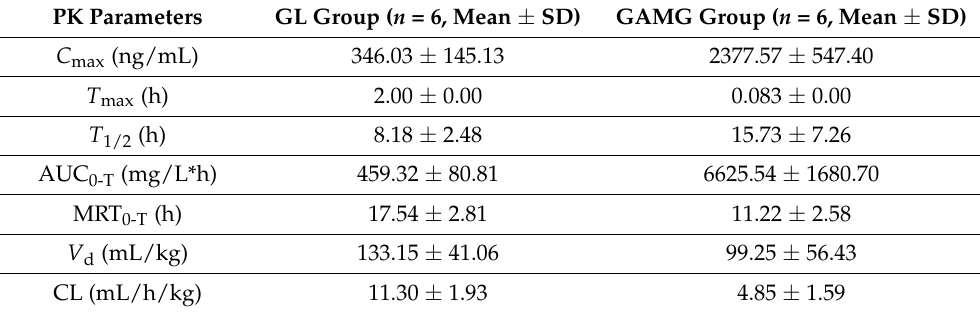
Figure 3. Average plasma concentration-time curve of each analyte (( A ): GAMG; ( B ): GA) after intragastric administration in rats ( n = 6). Table 8. Pharmacokinetic parameters of GAMG after intragastric administration of GL and GAMG ( n =